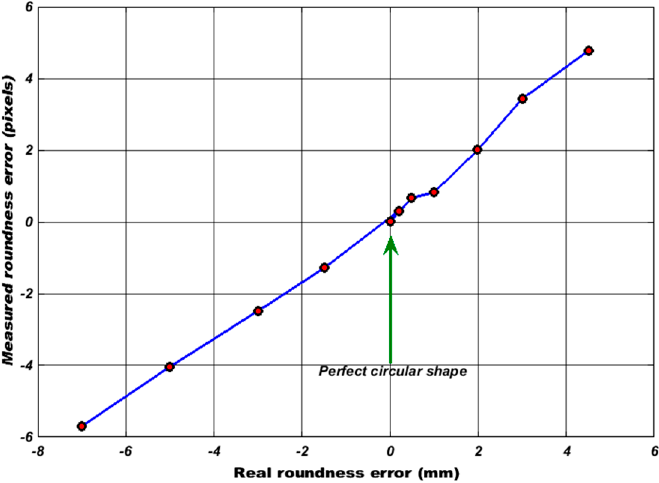
Figure 13. Roundness error measurements.